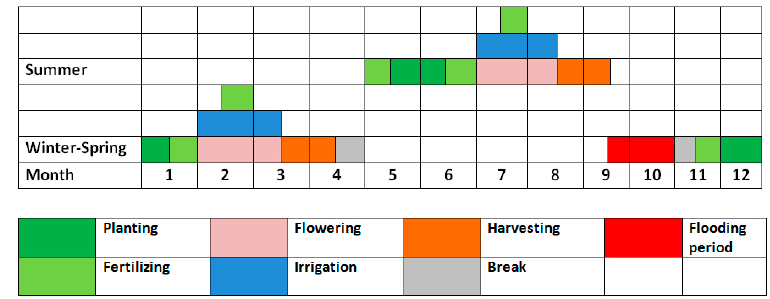
Figure 2. Paddy rice schedule plan in A-Luoi district.